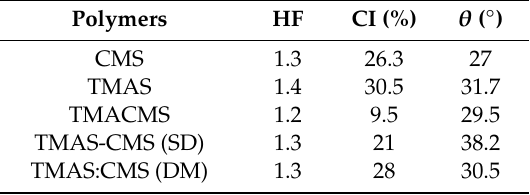
Table 1. Micromeritic properties of starch derivatives. HF: Hausner’s factor; CI: compressibility index. Polymers